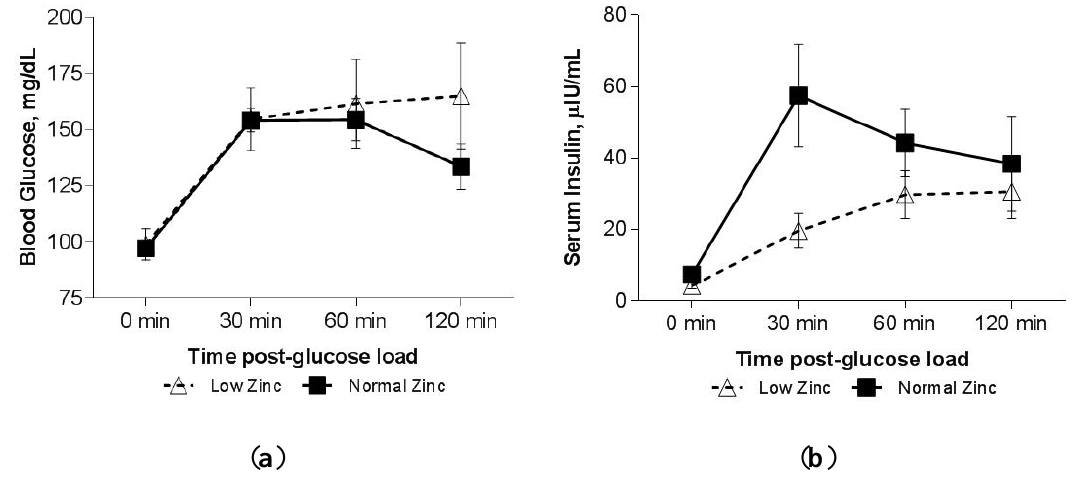
Figure 1. ( a ) Blood glucose response to a 75-g oral glucose load in patients with Thalassemia with normal ( n = 20) or low serum zinc ( n = 10). Using analysis of variance, a trend